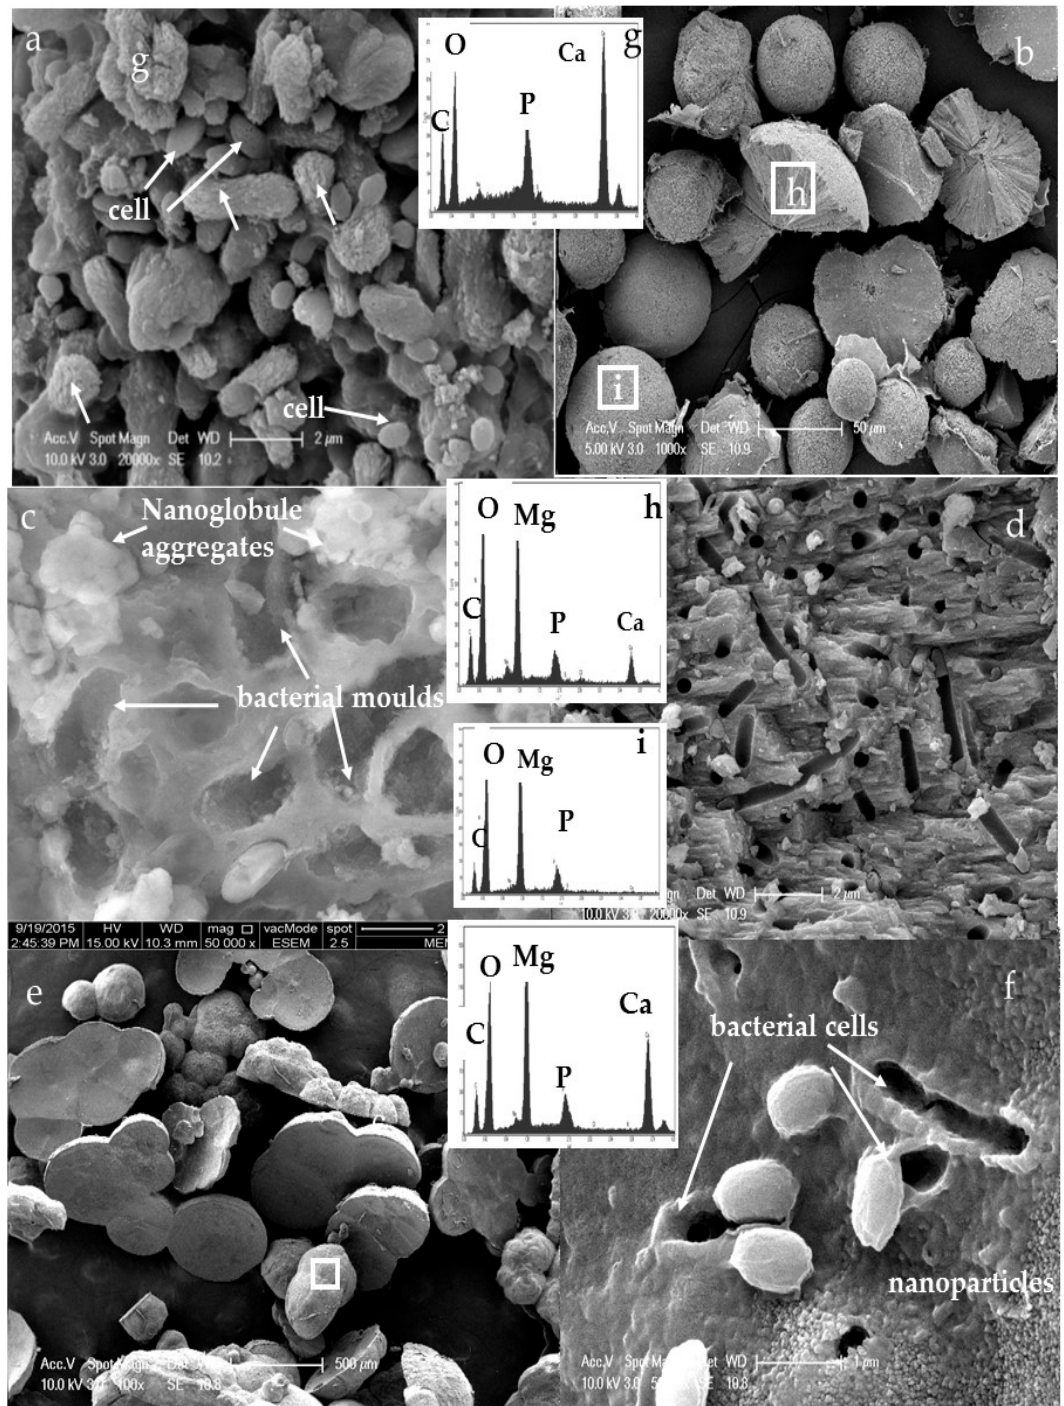
Figure 9. SEM photomicrographs of carbonate bioliths at the end of the experiments (37 days of incubation): ( a ) Calcite crystal (arrow indicate), drusiform calcite ( g ) formed accumulation of nanocrystals calcite with EDX in M3 experiment. ( b ) Isolated spherical bioliths. In square h hydromagnesite with fibrous radiated internal structure with EDX ( i ) (M8 experiment) and spheroidal hydromagnesite in square I. ( c ) A closer view of the area i square in b, note the nanoglobules around bacterial moulds (M7 experiment). ( d ) A closer view of the area h square in b, interior of fibrous radiated spherulite with reticulated zones and widespread bacterial moulds (M8 experiment). ( e ) Large spherulites and dumbbell shape bioliths (M6 experiment). ( f ) A closer view of the square area in e with EDX, surface of spherulite and the bacterial moulds is formed by aggregates of crystalline nanoparticles.